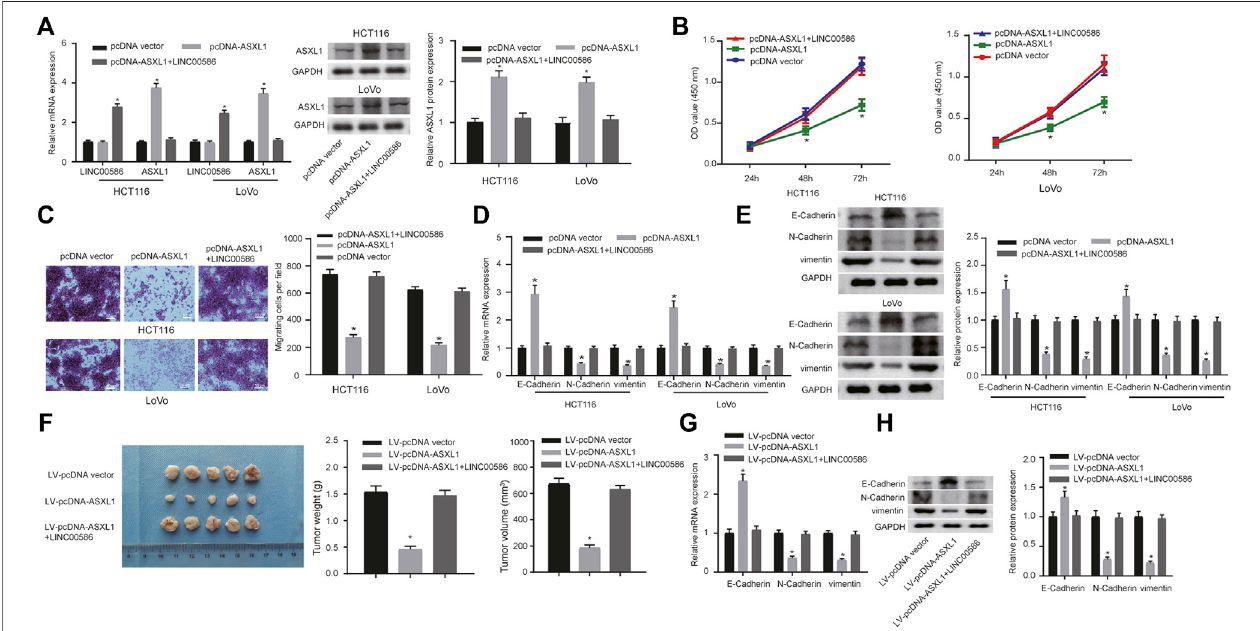
FIGURE 5 | LINC00586 modulates CRC cell viability, invasion, EMT, and tumorigenicity by inhibiting ASXL1. (A) The mRNA and protein expression of ASXL1 was determined in HCTl16 and LoVo cells upon ASXL1 overexpression and/or LINC00586 overexpression by real-time qPCR and immunoblotting analysis. (B) The viability ofHCTl16andLoVocellswasexaminedbyCCK-8testuponASXL1overexpression and/orLINC00586overexpression. (C) Representativeview(×200)ofHCTl16and LoVo cells migrating from upper transwell chambers into lower ones and statistics of migrating cells upon ASXL1 overexpression and/or LINC00586 overexpression. (D) The mRNA expression of E-Cadherin, N-Cadherin, and vimentin by real-time qPCR in HCTl16 and LoVo cells upon ASXL1 overexpression and/or LINC00586overexpression. (E) ImmunoblotsofE-Cadherin,N-Cadherin,vimentin,andtheirquantitativeanalysisinHCTl16andLoVocellsuponASXL1overexpression and/orLINC00586overexpression. (F) HCTl16cellswereinfectedwiththerecombinantlentivirusharboringthefulllengthofhumanASXL1genealoneorincombination with the recombinant lentivirus harboring human LINC00586 transcripts and injected into the nude mice ( n = 5), and the tumors were obtained 2 weeks after xenograft implantation and weighed. (G) The mRNA expression of E-Cadherin, N-Cadherin, and vimentin by real-time qPCR in CRC xenograft tissue sections upon ASXL1 overexpression and/or LINC00586 overexpression. (H) Immunoblots of E-Cadherin, N-Cadherin, vimentin, and their quantitative analysis in CRC xenograft tissue sections upon ASXL1 overexpression and/or LINC00586